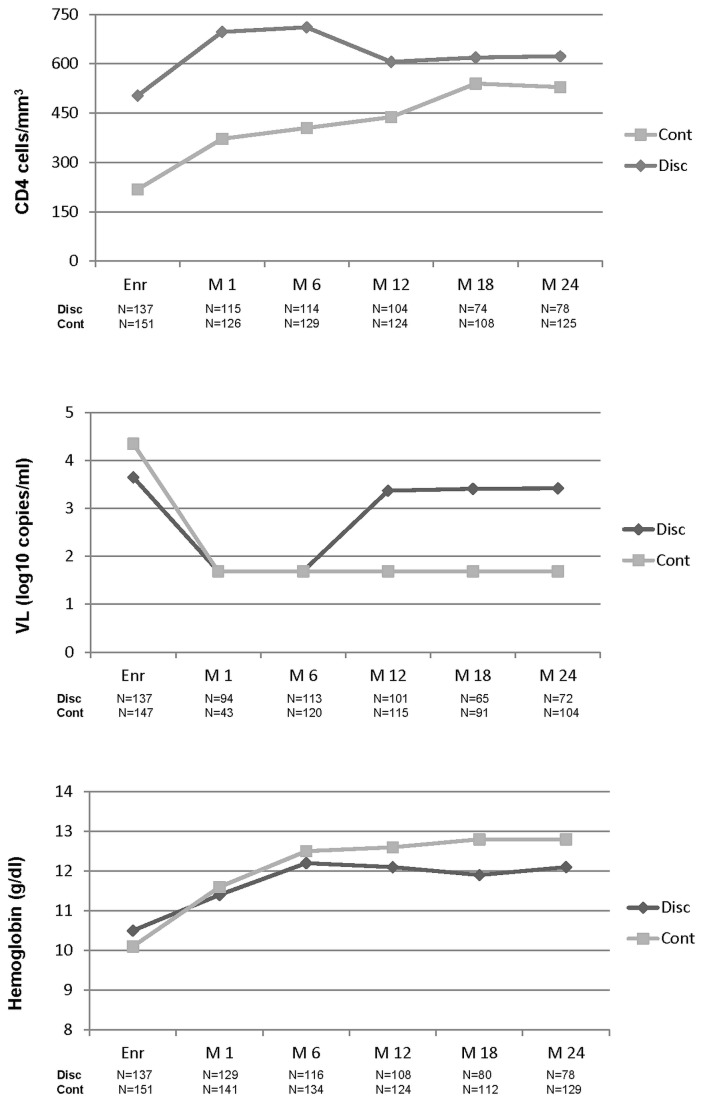
Longitudinal assessment of CD4+ count (median cells/mm3), viral load (median log10 copies/ml) and hemoglobin levels (median g/dl) in women in continuous therapy (Cont.) and in those who had discontinued treatment 6 months postpartum (Disc.).Analysis conducted on the 288 women who had an alive child and breastfed. Number of determinations available are reported for each timepoint. Data of women in the discontinuing group who resumed ART were included until treatment re-initiation.